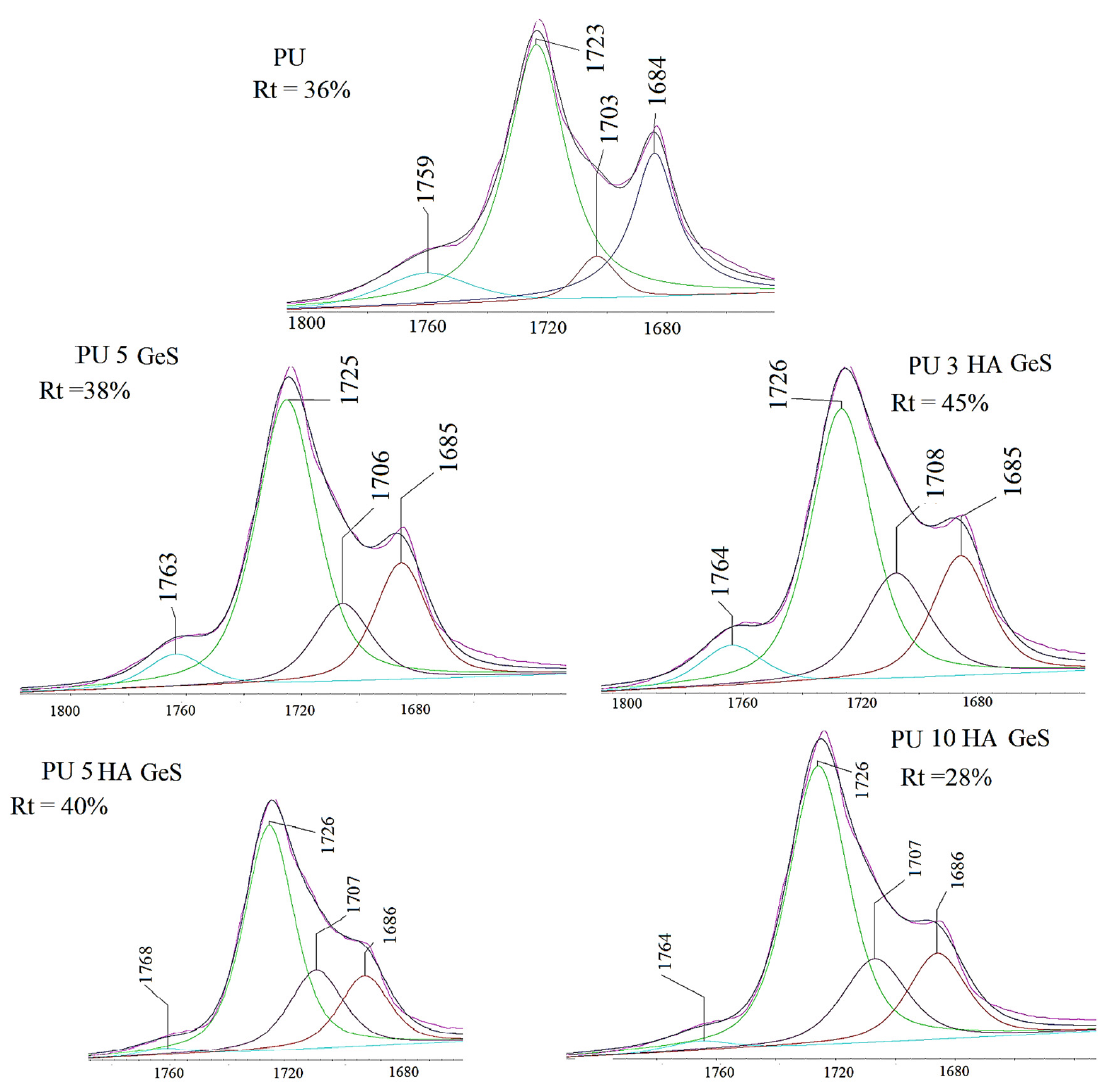
Figure 3. FTIR–ATR spectra of carbonyl region after deconvolution and Gaussian fitting. Rt—carbonyl hydrogen-bonding index.